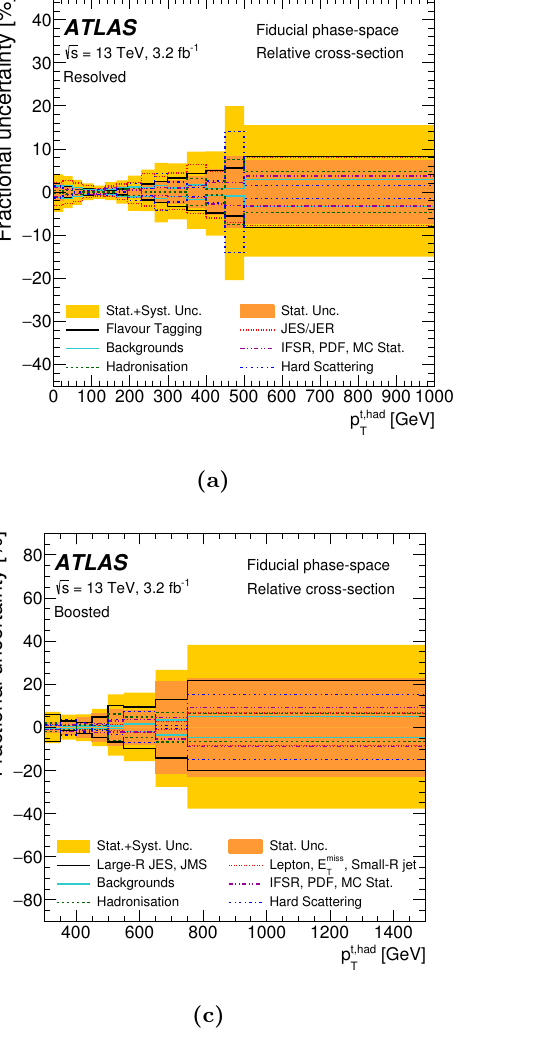
Figure 13. Uncertainties in the (cid:12)ducial phase-space relative di(cid:11)erential cross-sections as a func- tion of the (a) transverse momentum ( p t; had ) and (b) the absolute value of the rapidity ( T of the hadronic top quark in the resolved topology, and corresponding results in the boosted topology (c), (d). The yellow bands indicate the total uncertainty of the data in each bin. The Powheg + Pythia6 generator with h damp = m t and the CT10 PDF is used as the nominal prediction to correct for detector